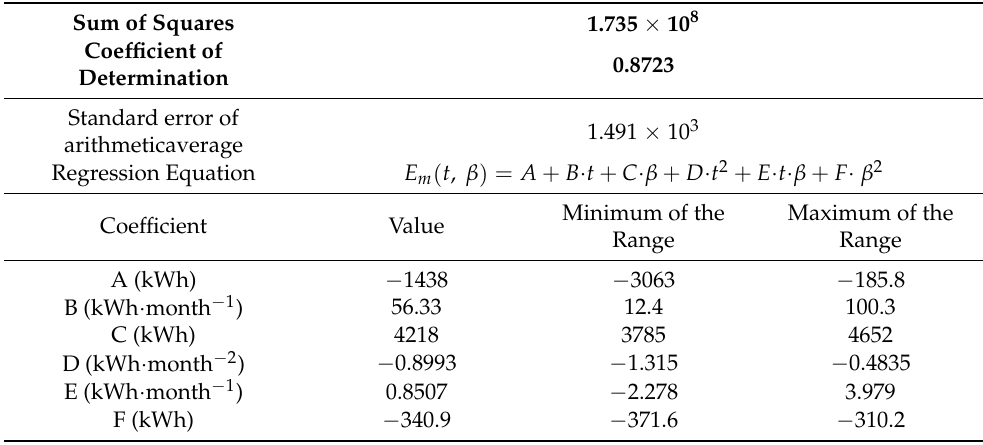
Figure 10. Three-dimensional dependence after polynomial approximation—the influence of tilt angle on the electric energy production of PV system for calendar months. Table 1. The statistical and regression characteristics of approximated polynomial function for three-dimensional dependence on Figure